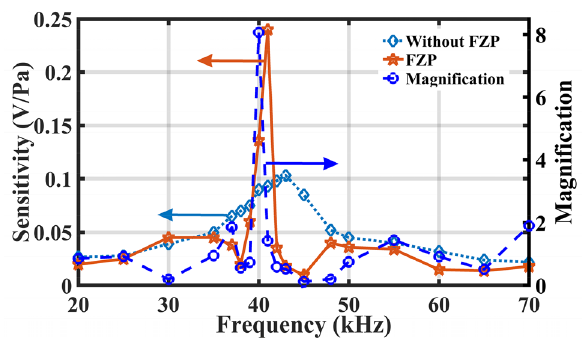
Figure 8. The sensitivity of the sensor with and without FZP versus ultrasonic